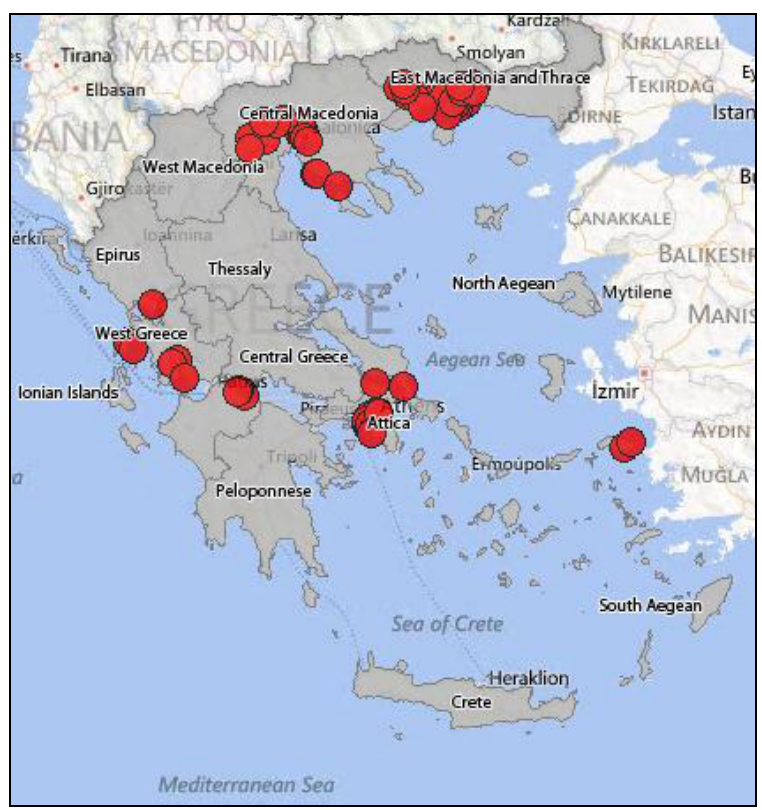
Figure 8. WNV human cases in Greece,